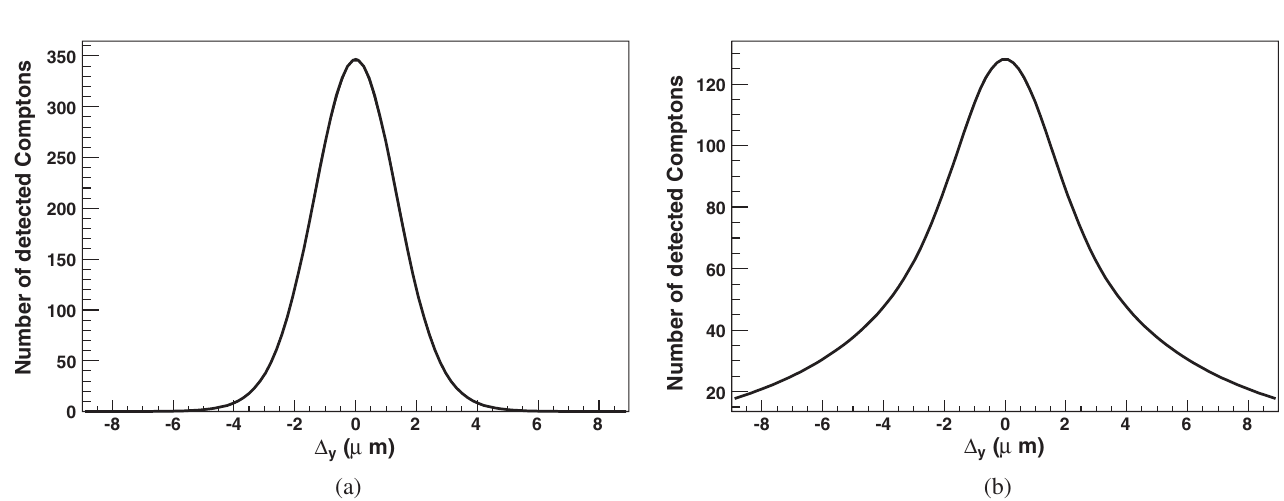
mode and focused 00 (cid:1) 1 (cid:3) m , (cid:2) (cid:1) 10 (cid:3) m . ey ex